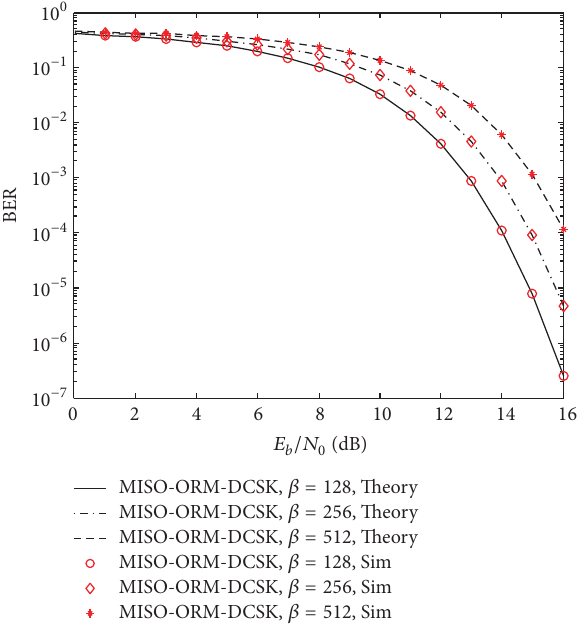
Figure 7: Relationships between analytical BER and Monte Carlo results for MISO-ORM-DCSK and MISO-RM-DCSK with 𝑁 = 2